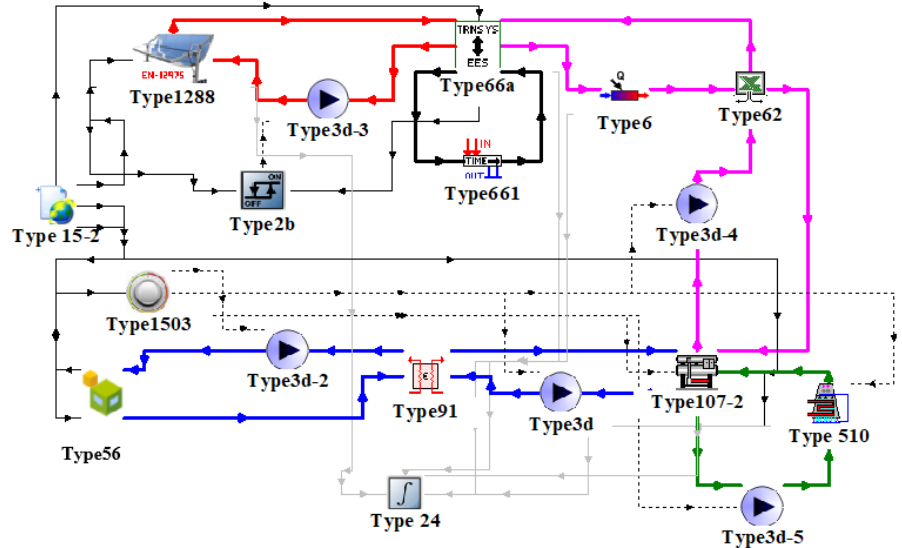
Figure 8. Diagram of the solar cooling system in TRaNsient SYstem Simulation (TRNSYS).